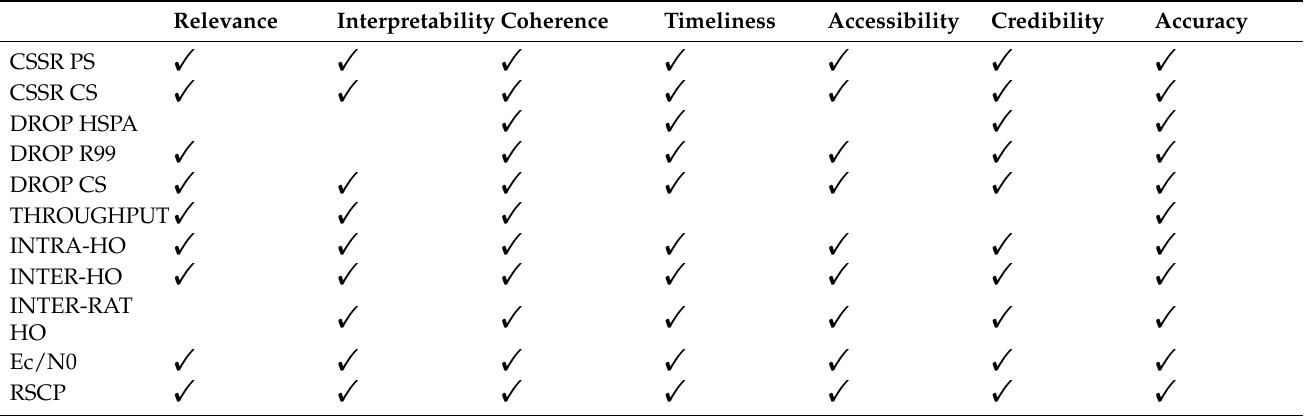
Table 1. Selected variables (KPIs). Fulfilling of requirements according to the methodology. Relevance Interpretability Coherence Timeliness Accessibility Credibility